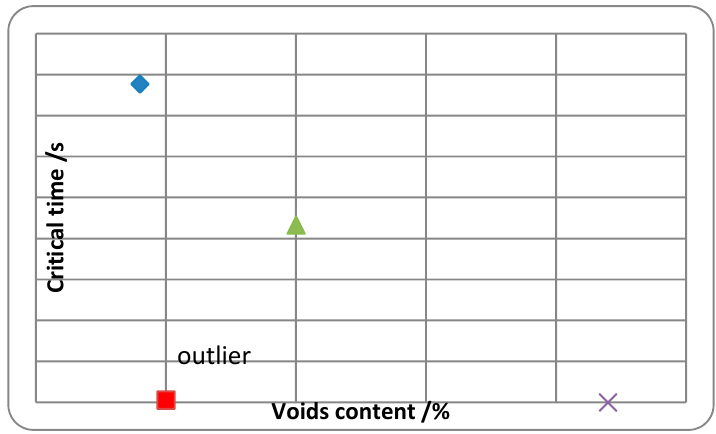
Figure 14. Relationship between the critical force and voids content.